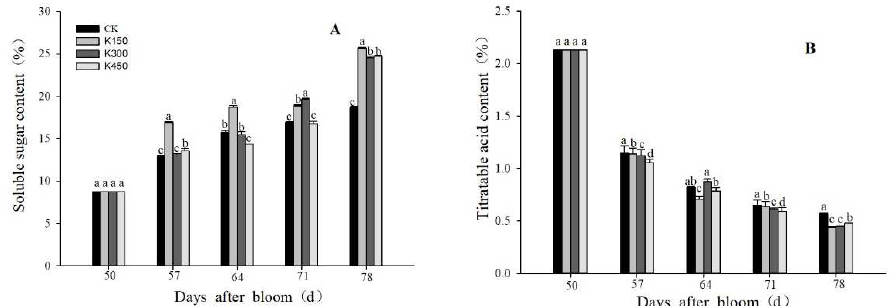
Figure 2. ( A ): Soluble sugar content in flesh. ( B ): Titratable acid content in flesh. Different lowercase letters indicate significant differences among the treatments (Duncan’s Multiple Range Test, p < 0.05).